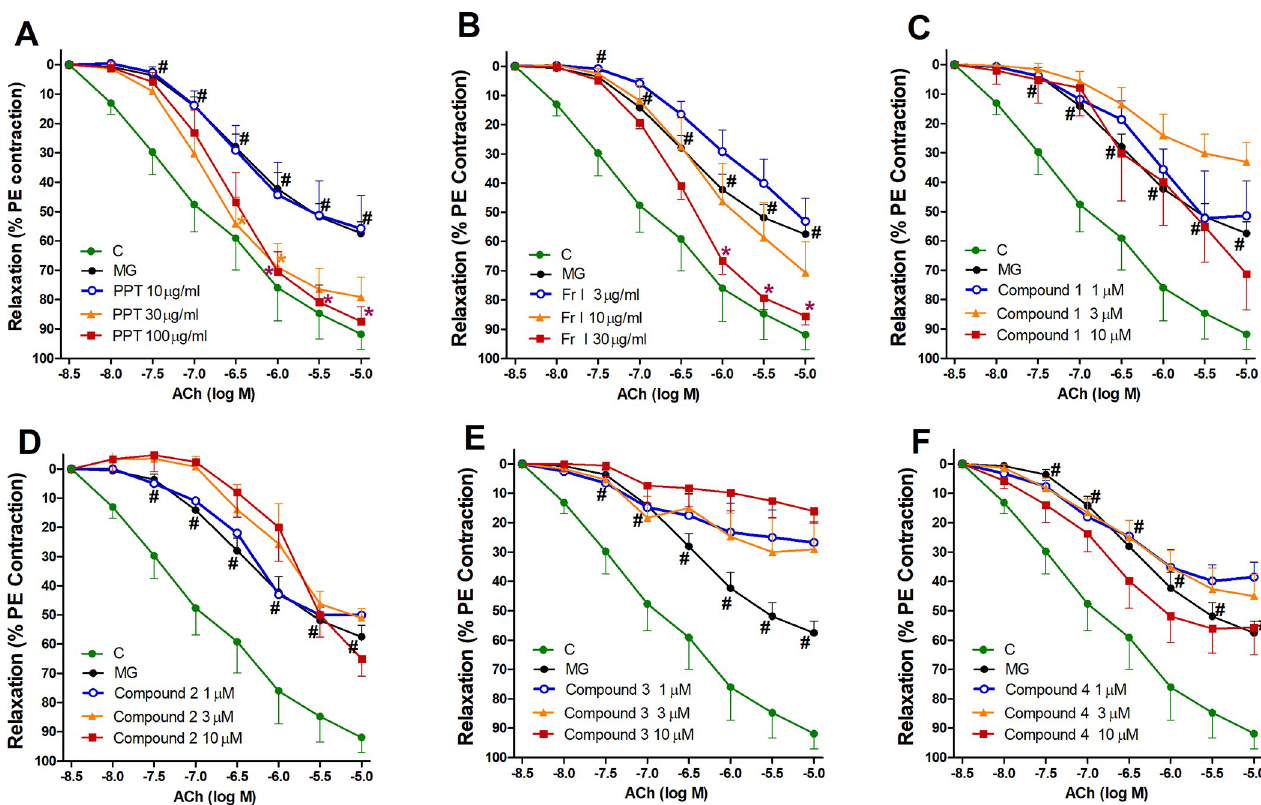
Fig 3. Effect of one-hour incubation of different concentrations of PPT (A), Fr. I (B), and isolated compounds 1–4 (C-F) on the AGEs-induced impaired vasorelaxant responsiveness to ACh of aortae isolated from normal rats. #P < 0.05, compared with the corresponding control values; � P < 0.05, compared with MG group; by Tow Way ANOVA and Bonferroni post hoc